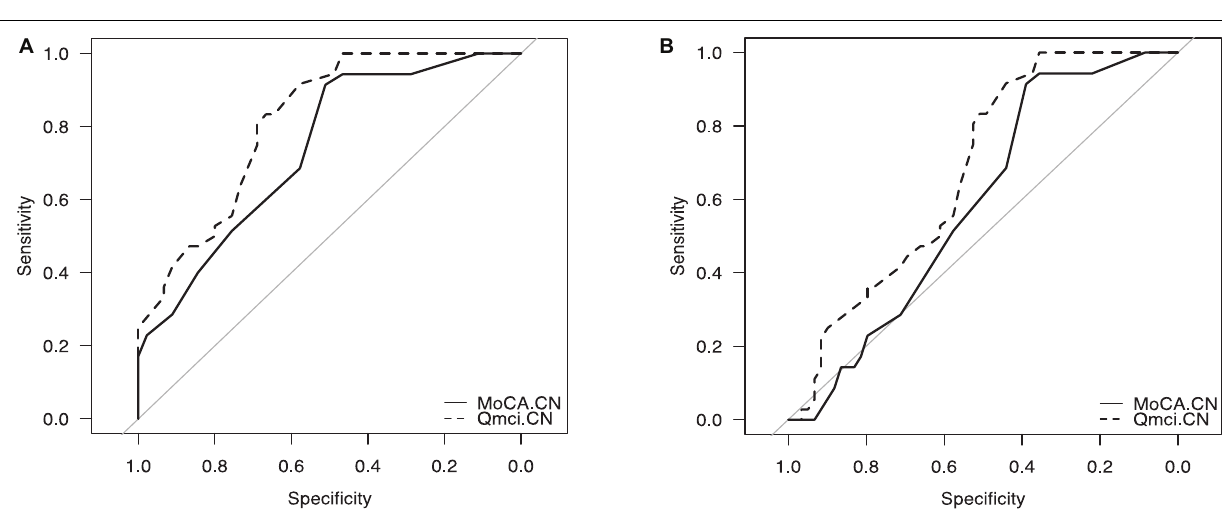
FIGURE 2 | Receiver Operating Characteristic (ROC) curve analysis comparing the Chinese versions of the Quick Mild Cognitive Impairment (Q mci -CN) screen and Montreal Cognitive Assessment (MoCA-CN) in identifying (A) cognitive frailty from non-frailty and (B) cognitive frailty from other patients presenting with symptomatic memory